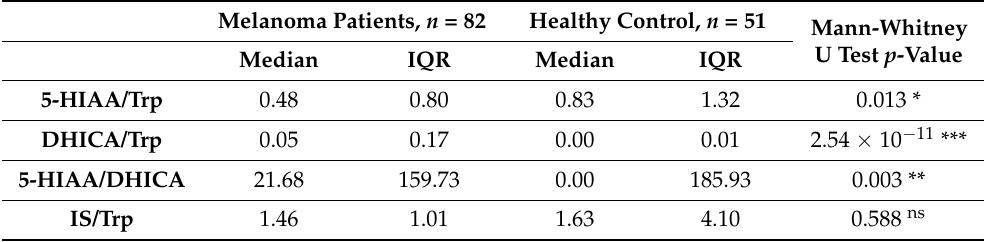
Table 4. Urinary 5-HIAA/Trp, DHICA/Trp, and 5-HIAA/DHICA ratios characteristic of the sero- tonin pathway and IS/Trp characteristic of the indole pathway. Melanoma Patients, n = 82 Healthy Control, n = 51